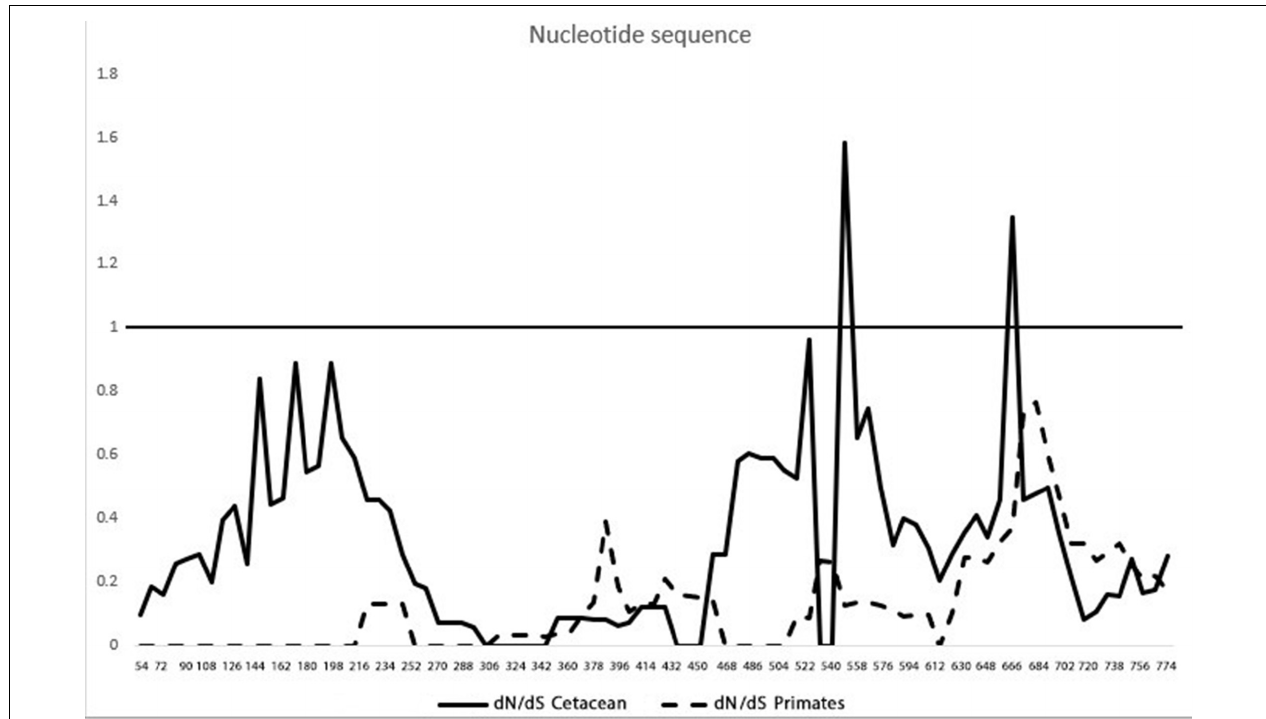
FIGURE 6 | Different non-synonymous/synonymous substitution (dN/dS) rates along the coding sequence of the heme oxygenase-1 gene ( hmox1 ). The solid line is the pairwise dN/dS rate within cetaceans. The dashed line represents the pairwise dN/dS rate in